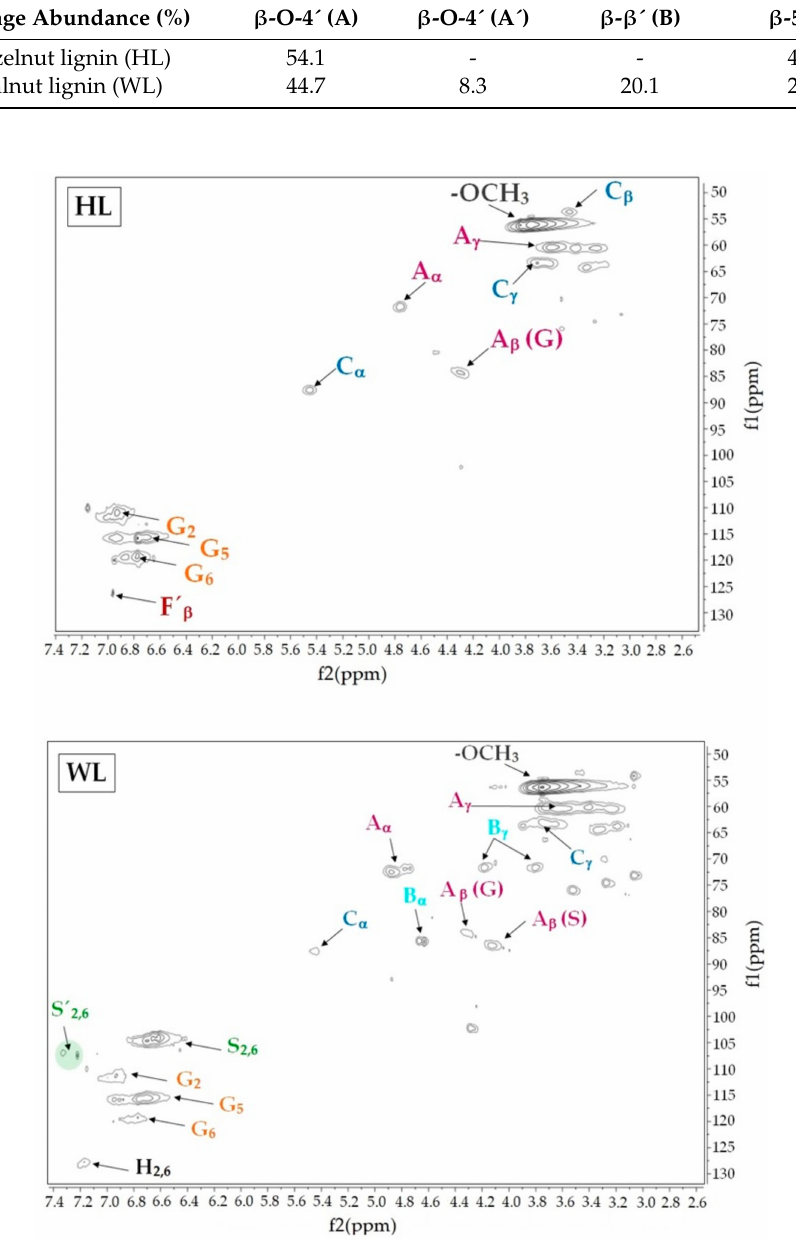
Figure 1. Side chain and aromatic regions of 2D HSQC NMR spectra of isolated